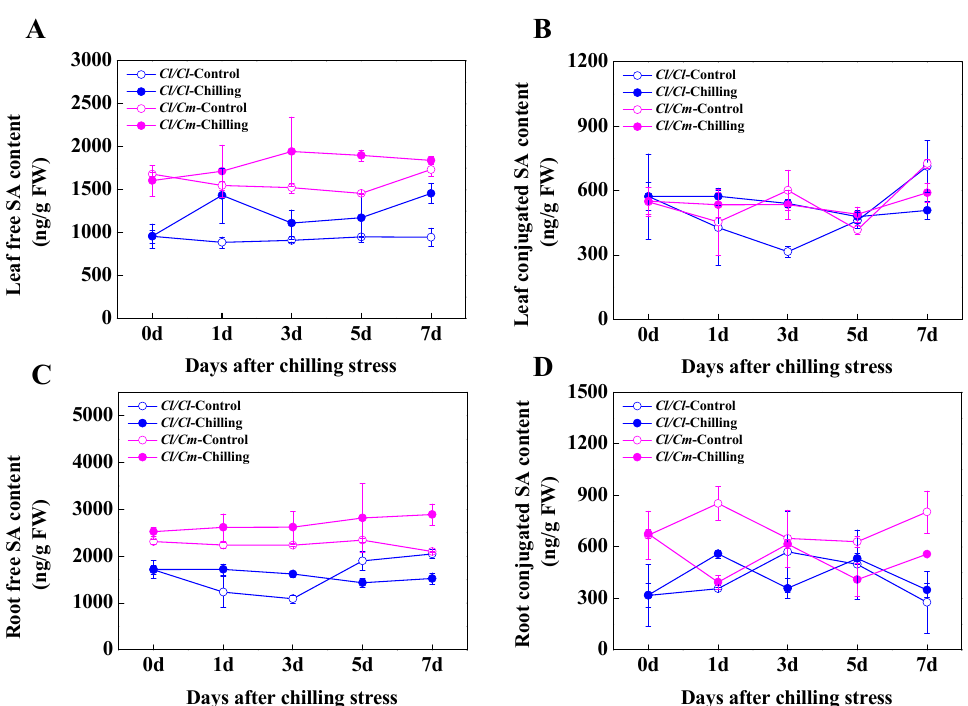
Figure 4. The spatio–temporal response of salicylic acid (SA) content to chilling stress in grafted watermelon plants. ( A ) Free and ( B ) Conjugated SA content in the leaves. ( C ) Free and ( D ) Conjugated SA content in the roots. Leaf or root samples were collected at indicated times under control (28/18 °C) and chilling (10/5 °C) conditions. Cl / Cl , self-grafted watermelon plants; Cl / Cm , pumpkin rootstock-grafted watermelon plants. The data are the means of four replicates with SEs.